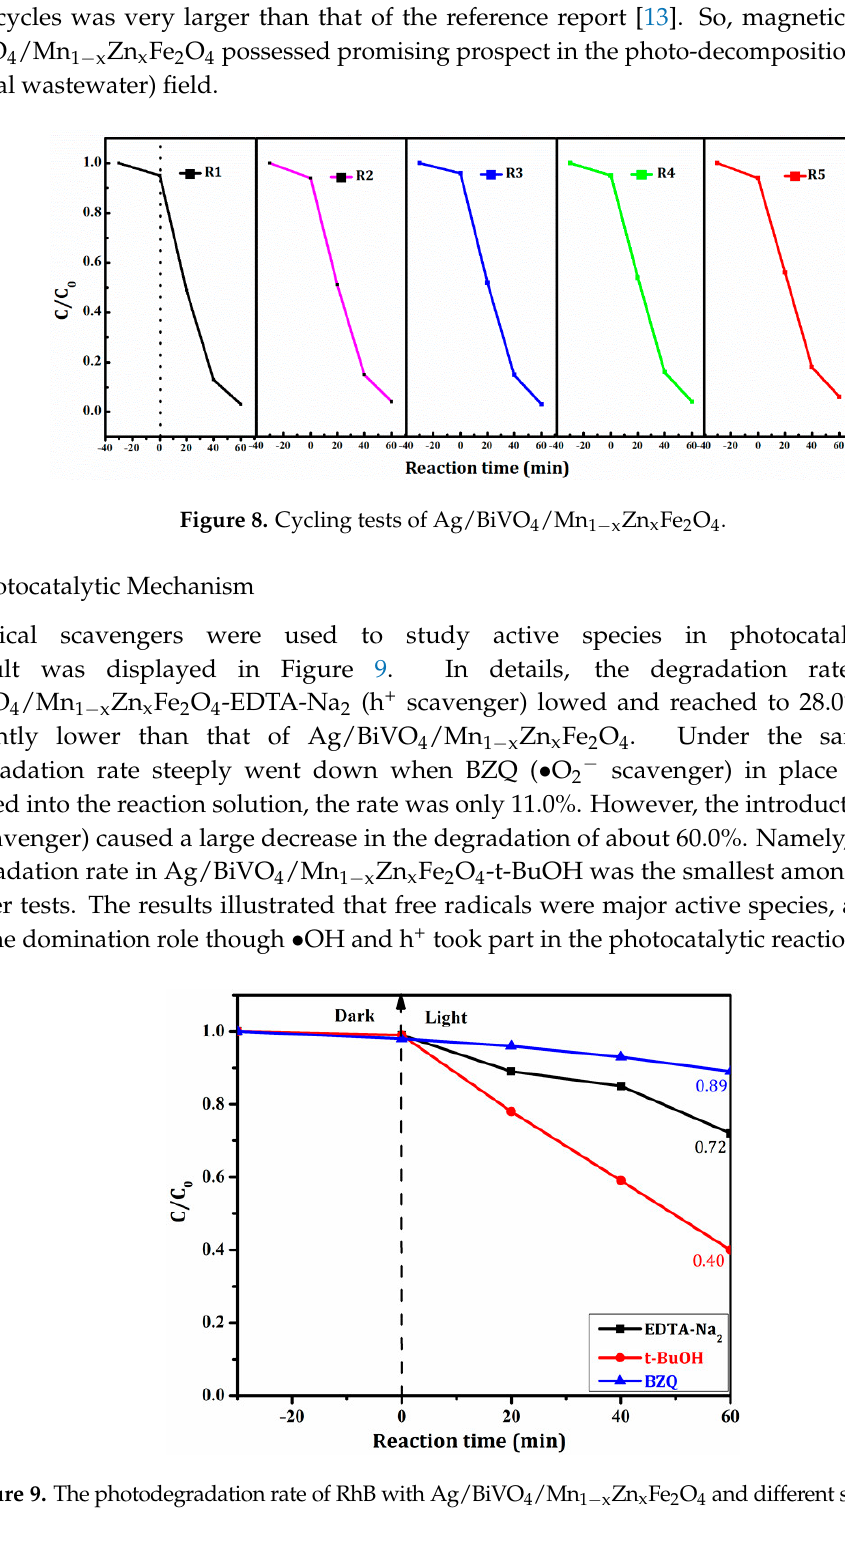
Figure 9. The photodegradation rate of RhB with Ag/BiVO 4 /Mn 1 − x Zn x Fe 2 O 4 and different scavengers.